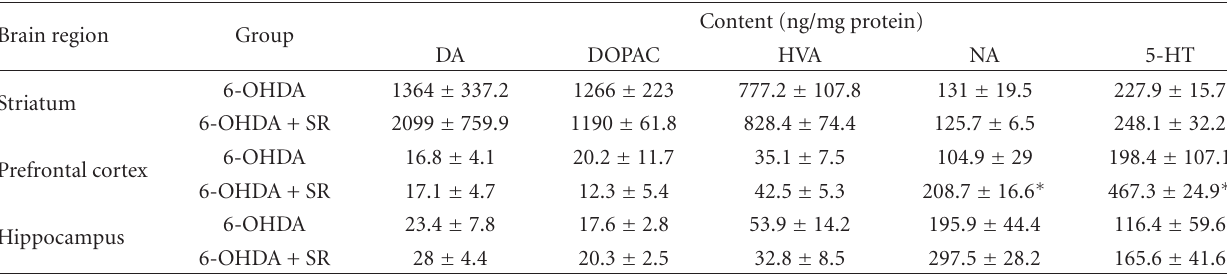
Table 2: E ff ects of acute administration of SR141716A (0.5mg/kg) i.p. on neurotransmitter levels in the striatum, prefrontal cortex, and hippocampus three weeks after 6-OHDA administration. Results are expressed as mean ± SEM in comparison to the 6-OHDA group. Statistical analysis was performed by unpaired Student’s t